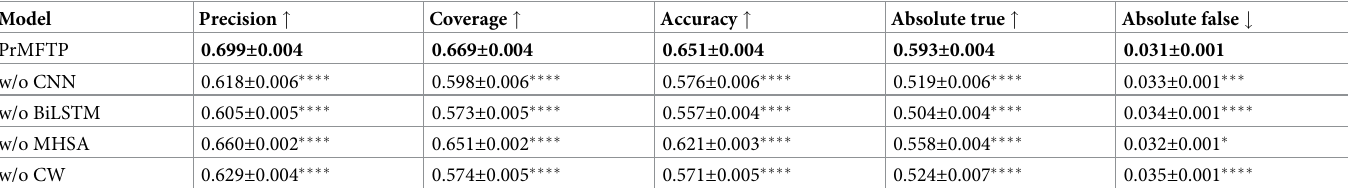
Table 3. The performance of PrMFTP and their variants on the test set. The highest value is highlighted in bold. w/o is abbreviation of without. The mean ± standard deviation on 5-fold cross-validation is shown for models. � , �� , ��� and ���� mean that PrMFTP is significantly better at P-value < 0.05, P-value < 0.01, P-value < 0.001 and P-value < 0.0001 (t-test),